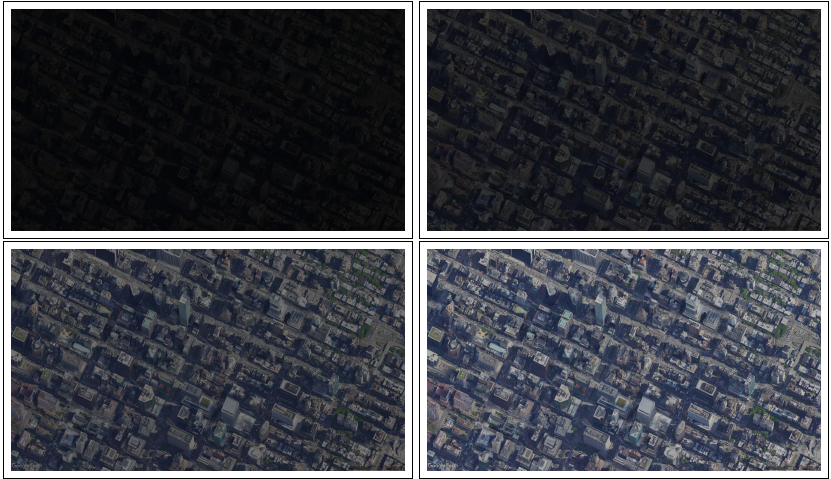
Figure 9. The view of an urban location (location #1) from an altitude of 1.2 km in various lighting conditions (ranging from 75 to 10%